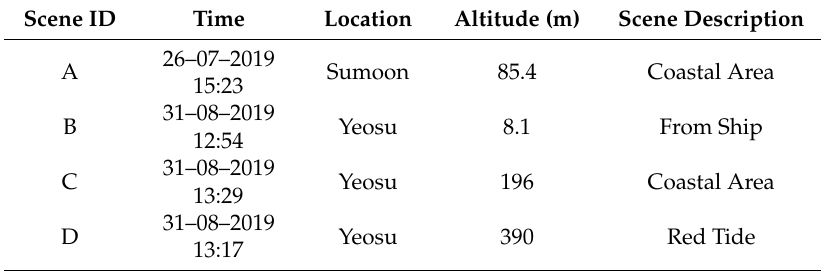
Figure 3. ( a ) The map of study site near Yeosu, a southern coast of Korea, and the bounding box (orange) for the area that the unmanned aerial vehicle (UAV) was operated for, and ( b ) photographs of the multispectral-UAV system configured with the downwelling light sensor (DLS), the RGB camera, and the multispectral camera. Table 1. Data list used in this study.